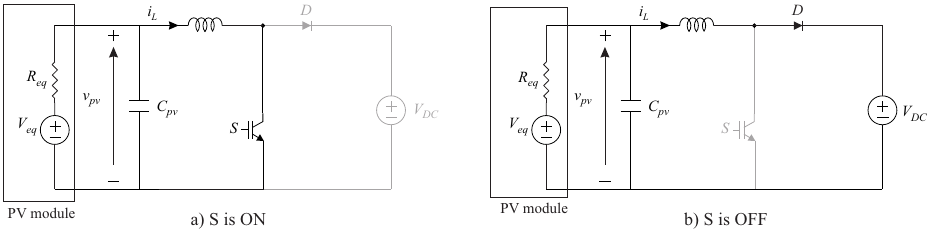
Figure 2. Block diagram of the